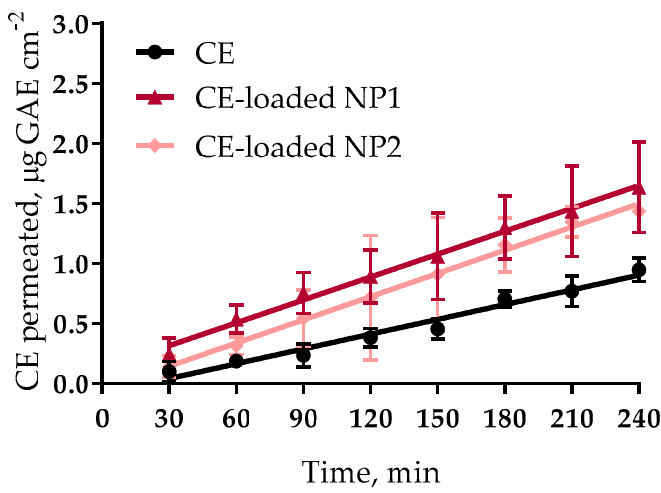
Table 2. Data on CE permeation across excised rat jejunal epithelium from phosphate buffer (PB, PH = 7.4) containing CE alone or encapsulated in NPs (15.5 μ g/mL gallic acid equivalent (GAE).